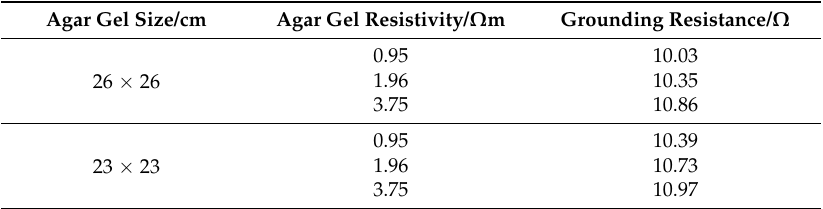
Table 2. The changes in grounding resistance with agar resistivity under different sizes.